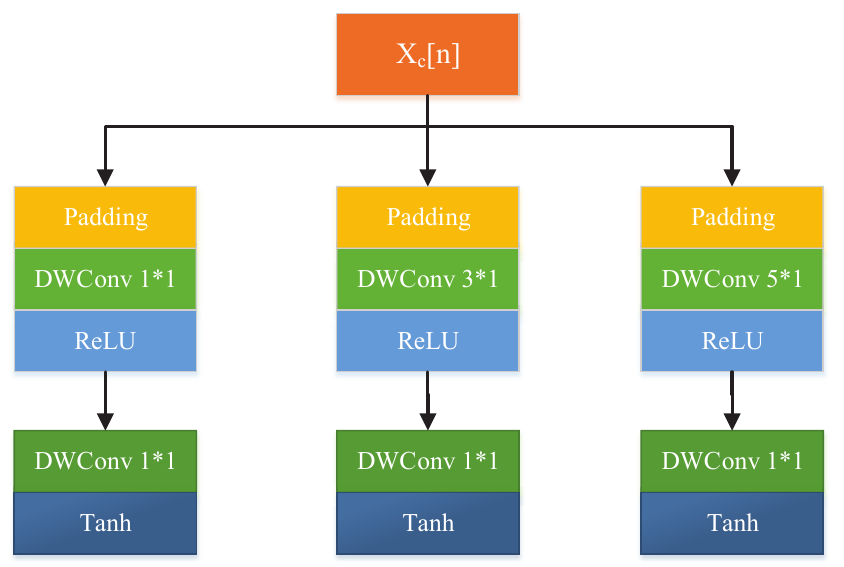
Figure 4. The structure of the predictor. Padding in the predictor denotes the reflection padding.